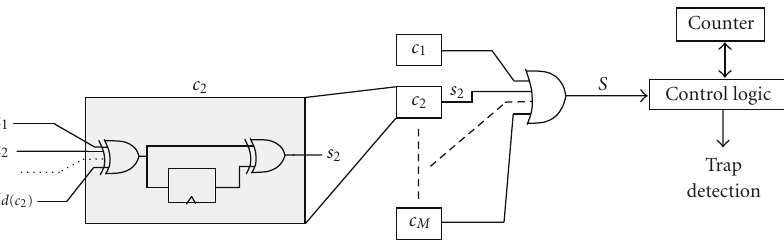
Figure 5: Decoder trap detection circuit.